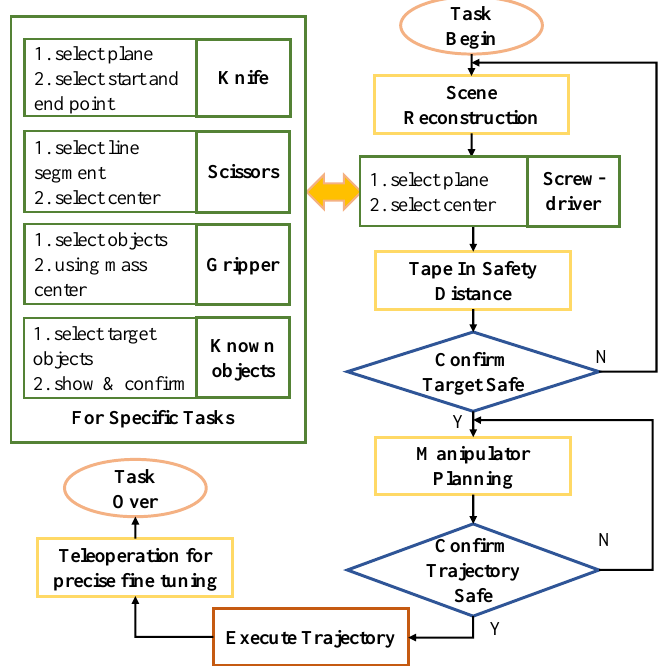
Figure 8. Flowchart of the point cloud-assisted teleoperation